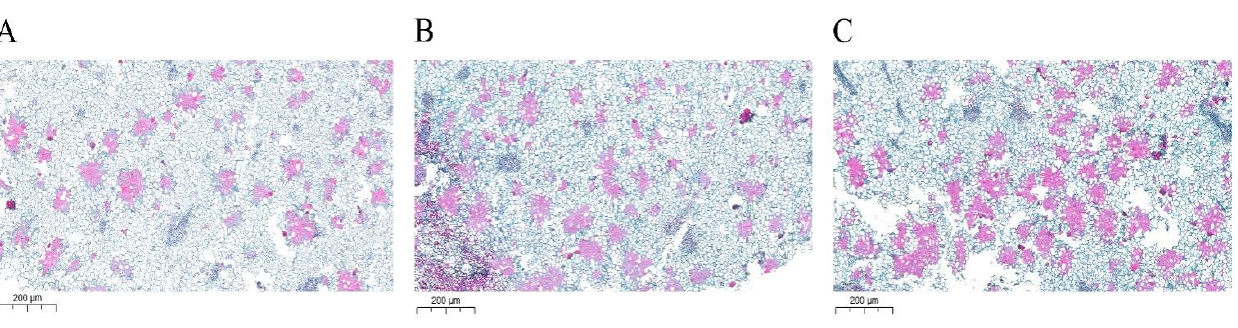
Figure 8. Observation of safranin-fast green staining in fruits of “Dangshansu” pear transiently overexpressed by PbrSAUR13,52. ( A ) Safranin fast green staining of pCAMBIA1304 empty pear fruit; ( B ) Safranin fast green staining in pear fruit overexpressing by PbrSAUR13 ; ( C ) Safranin fast green staining in pear fruit overexpressing by PbrSAUR52 .